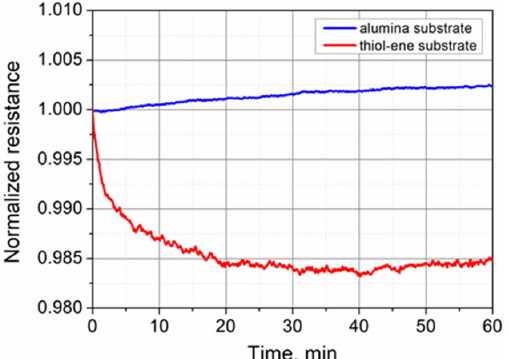
Figure 6. Normalized electrical resistance of PEDOT:PSS films on alumina and thiol–ene substrates versus time over a 60 min period. versus time over a 60 min